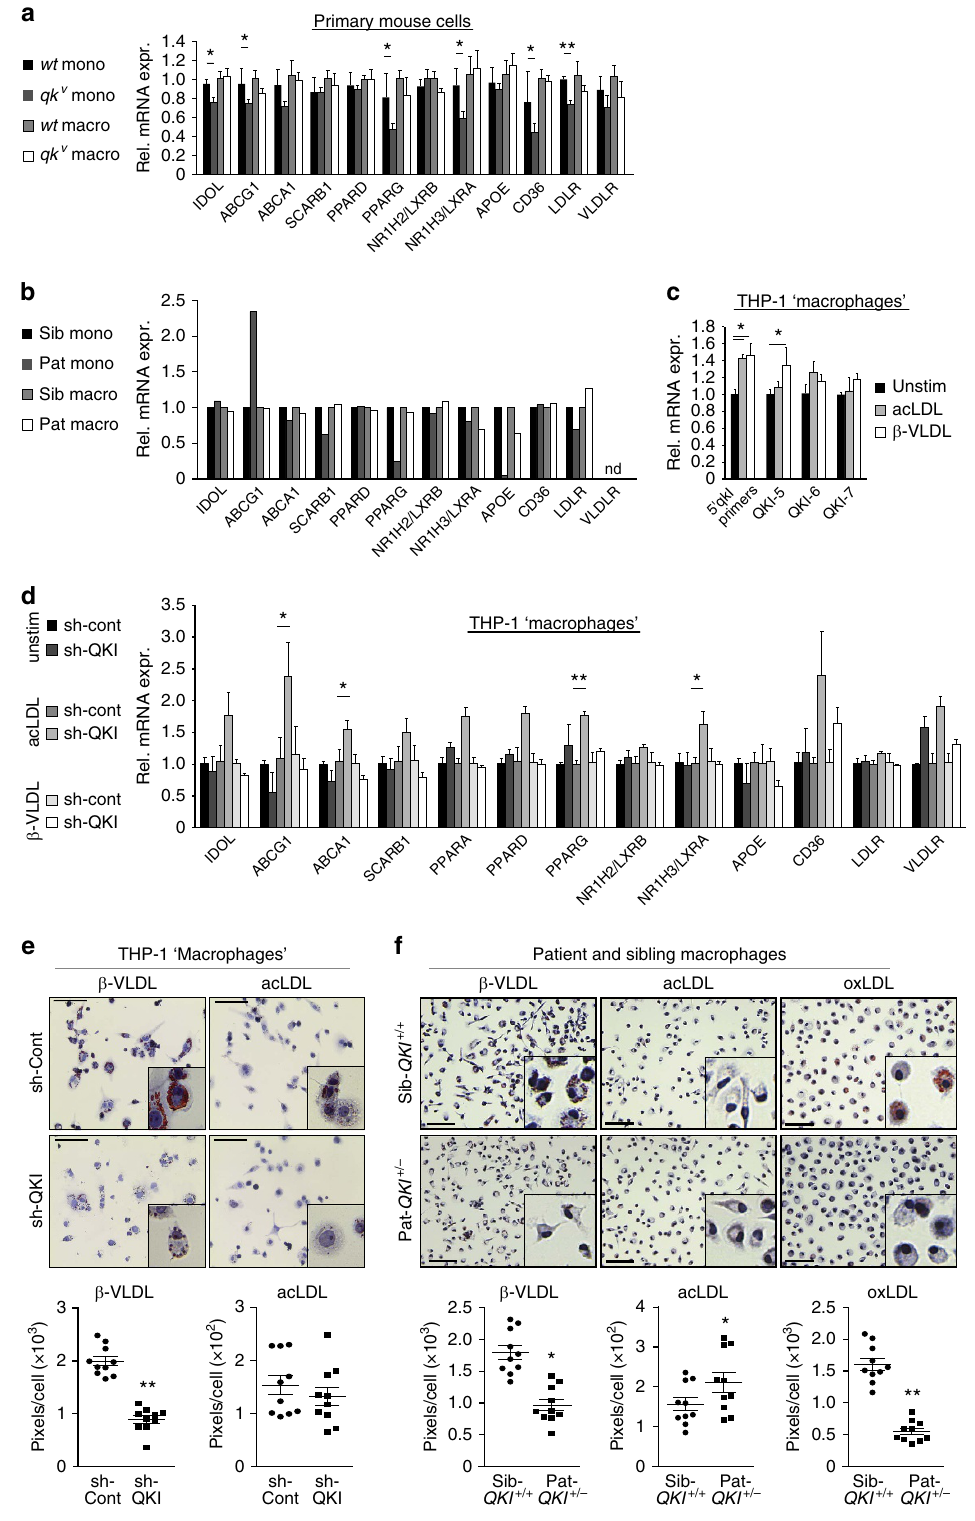
NATURE COMMUNICATIONS|7:10846|DOI: